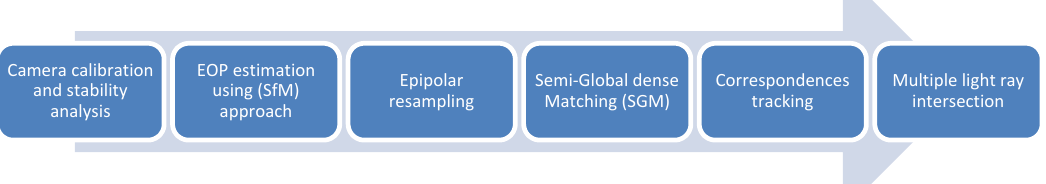
Figure 8. Proposed dense 3D reconstruction procedure.